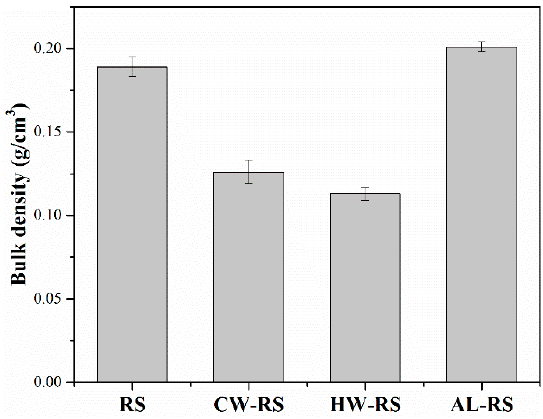
Figure 5. Bulk density of RS, CW-RS, HW-RS, and AL-RS.